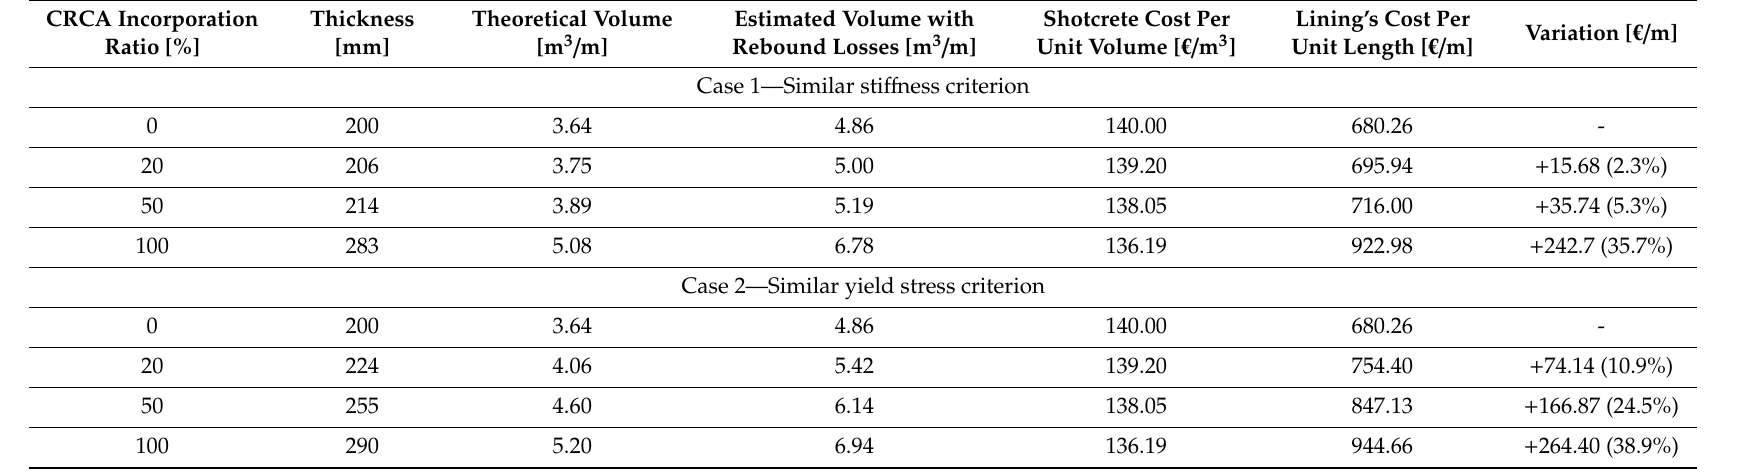
Table 9. Lining cost per unit length of the tunnel for Scenario 1 (50% Coarse Natural